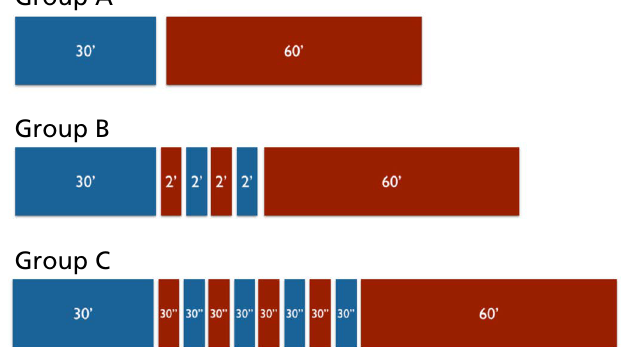
Fig. 1 - Schematic demonstration of periods of ischemia and reperfusion in groups A, B and C (the numbers correspond to the time in minutes; blue: ischemia; red: